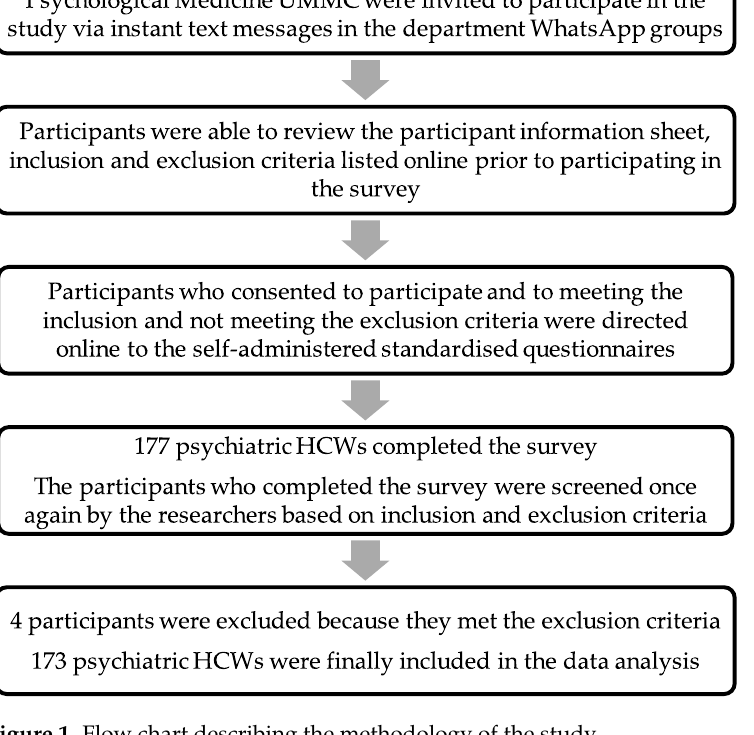
Figure 1. Flow chart describing the methodology of the